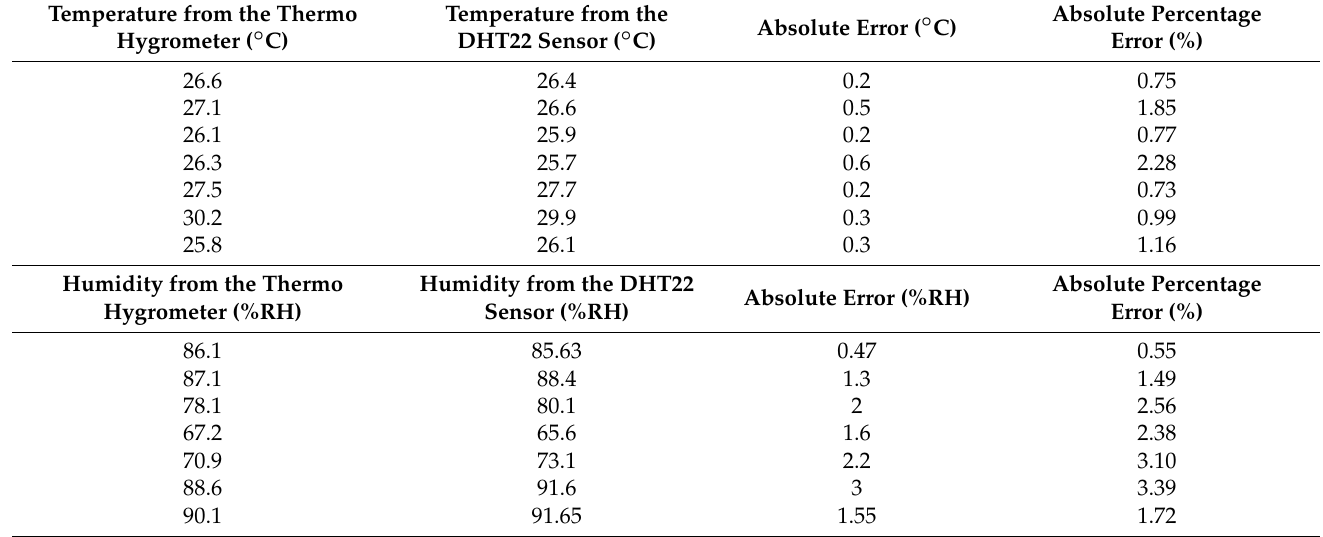
Table 3. Comparison of the temperature and humidity between thermo hygrometer and the DHT22